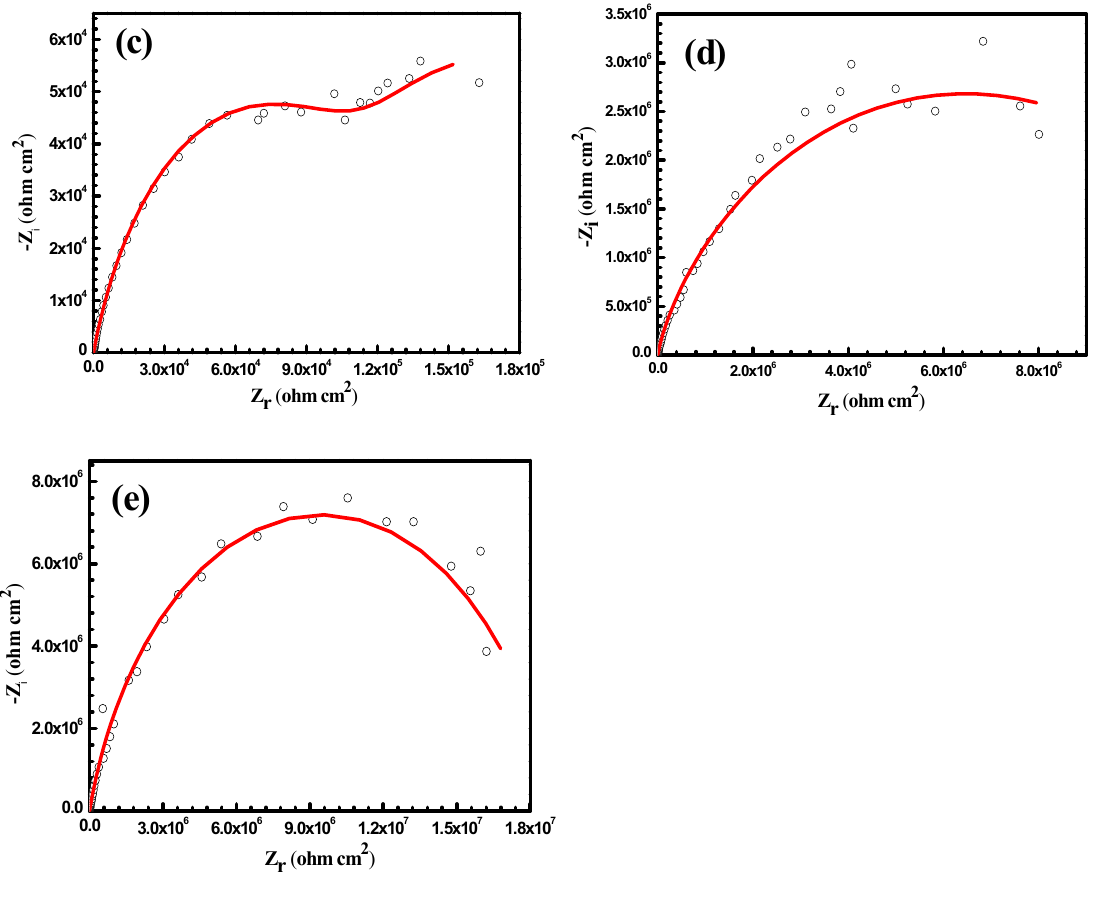
Figure 7. Nyquist plots of the ( a ) uncoated Al alloy ( b ) PS1, ( c ) PS3, ( d ) PA1, and ( e ) PA3 from the EIS measurements in 3.5 wt % NaCl. measurements in 3.5 wt % NaCl.